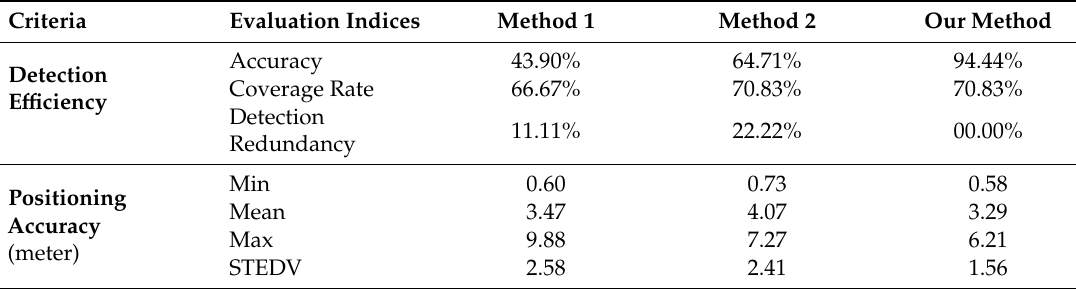
Table 2. Performance comparison among three